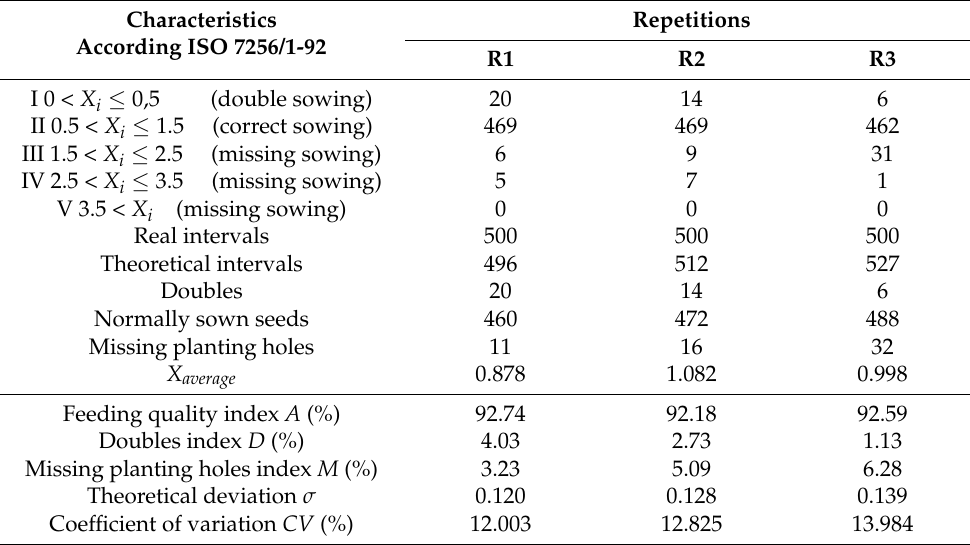
Table 6. Seed distribution and determination of the quality indices of the BV row unit, for a density of 50,000 corn plants · ha − 1 and the working speed of 4 km · h − 1 , on the plot with appropriate degree of seedbed processing.